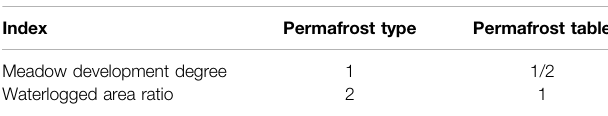
TABLE 12 | Judgment matrix of wetlands